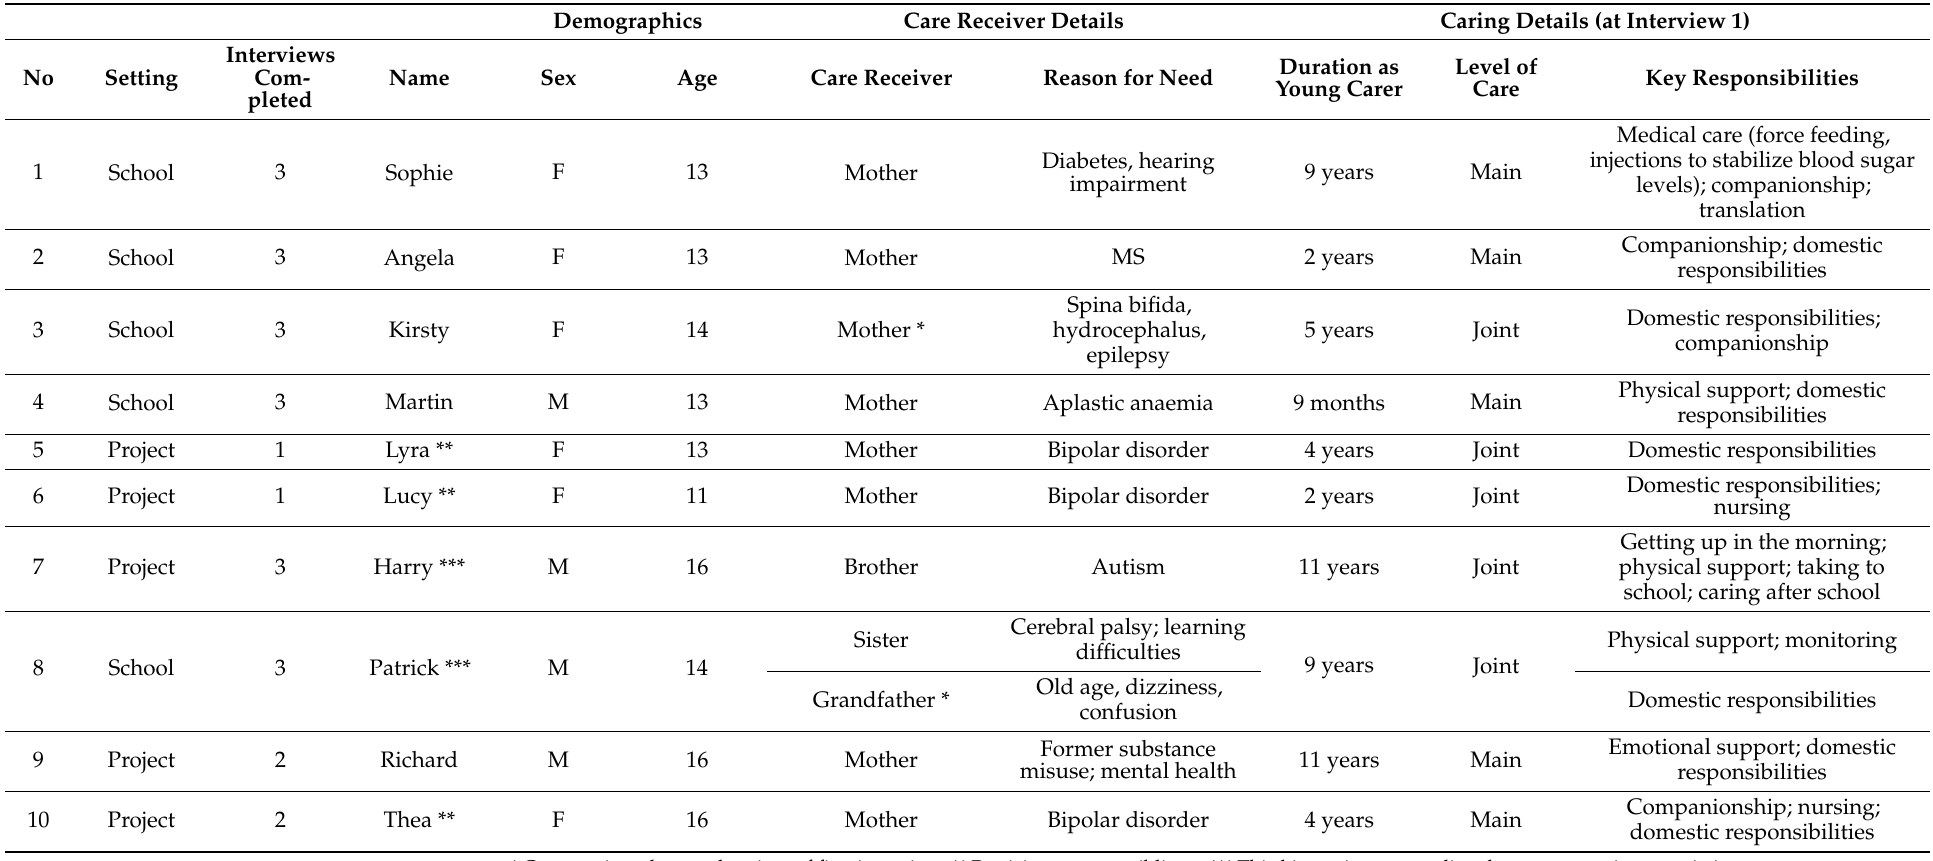
Table 1. Participant sample